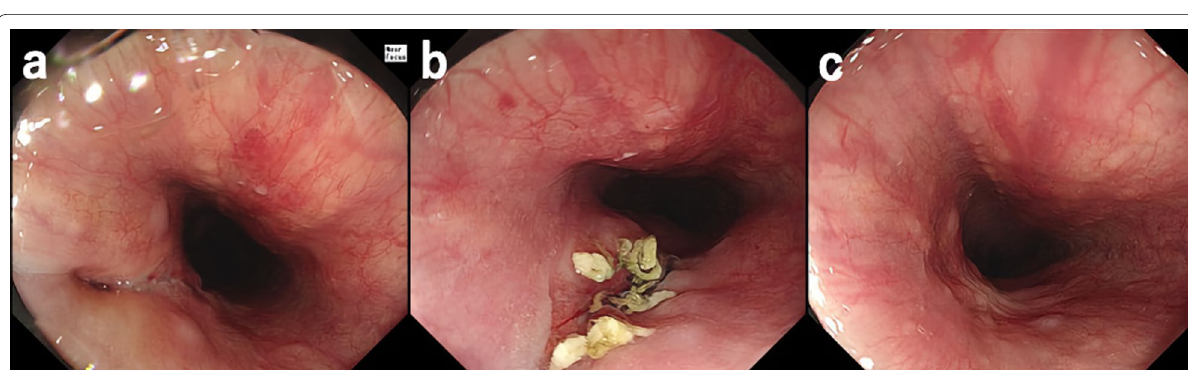
Fig. 5 Postoperative endoscopy. a Two weeks after the surgery. b A month after the surgery. c Three months after the